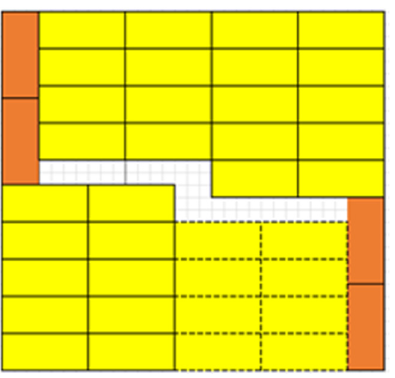
Figure 18. Horizontal overlap object mark.